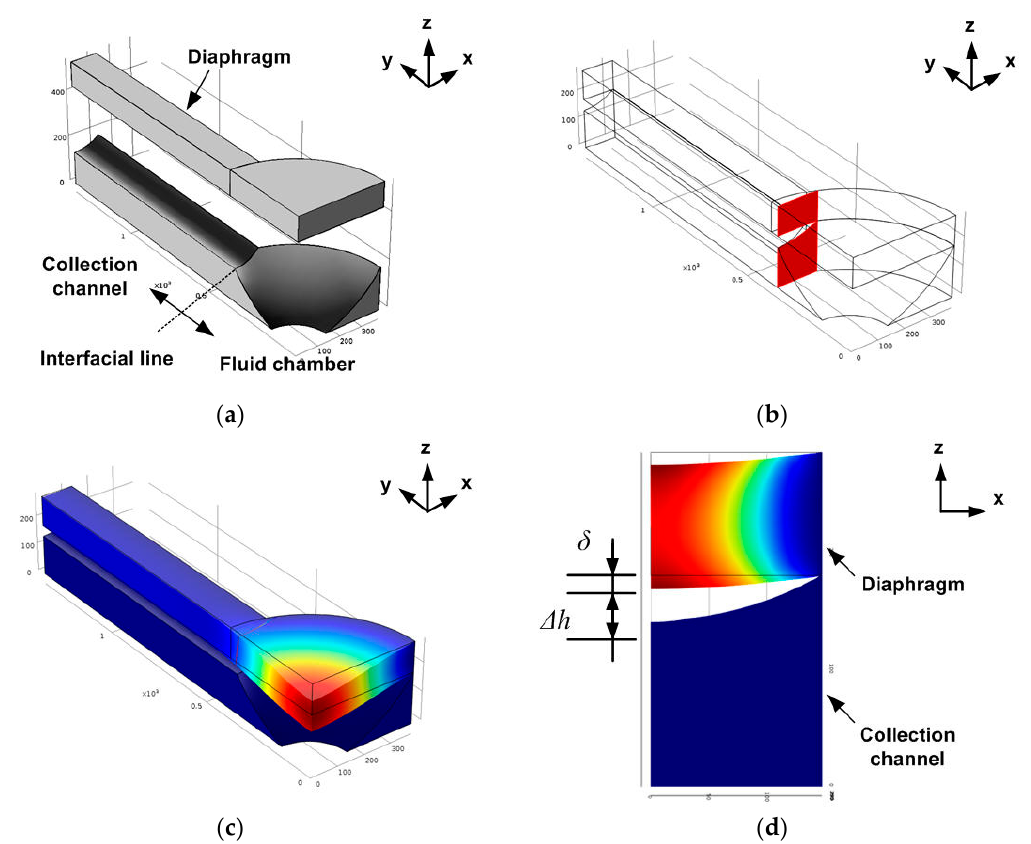
Figure 5. Finite element method (FEM) simulation results. ( a ) The FEM model, ( b ) the cut-plane at the interface of the collection channel and fluid chamber of the Vs, ( c ) structural deformation of the valve diaphragm when a pressure of 10 kPa was applied, ( d ) diaphragm deformation at the cut-plane.